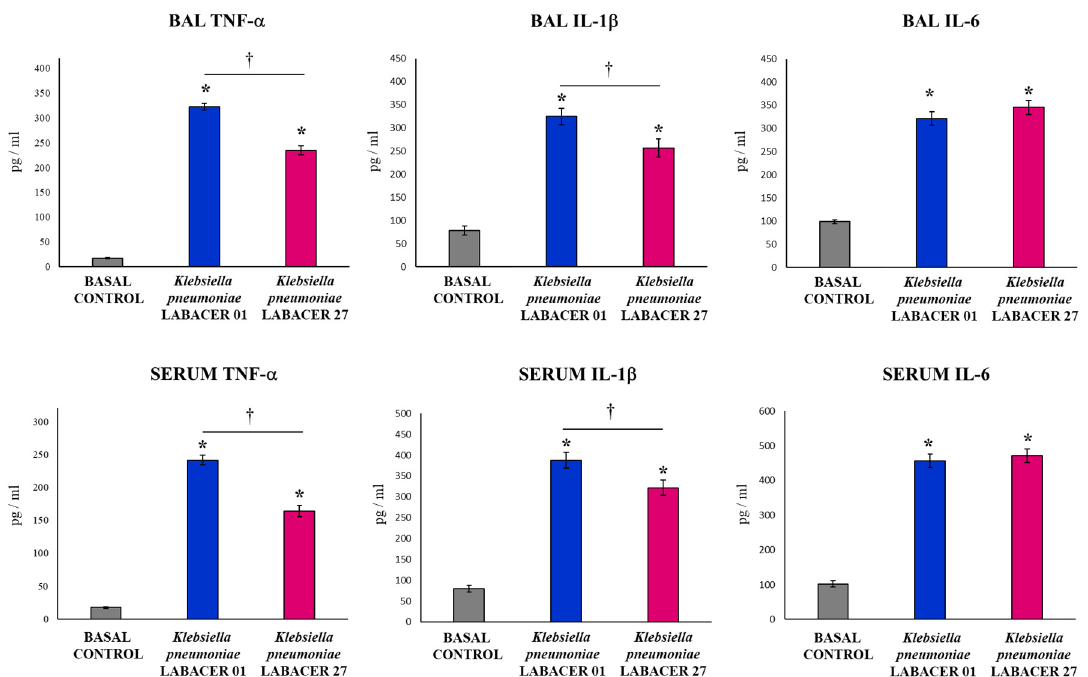
Figure 3. Variations in inflammatory cytokines in the respiratory tract and blood induced by KPC-2-producing hypermucoviscous ST25 strains of Klebsiella pneumoniae . Immunocompetent adult BALB/c mice (six weeks) were nasally challenged with K. pneumoniae LABACER 01 or LABACER 27. Two days after challenge, the TNF- α , IL-1 β , and IL-6 levels were determined in broncho-alveolar lavage (BAL) and blood samples. Results represent data from three independent experiments. Asterisks (*) indicate significant differences from the uninfected control group (basal control), p < 0.05. The crosses (†) indicate significant differences between the indicated groups, p < 0.05.